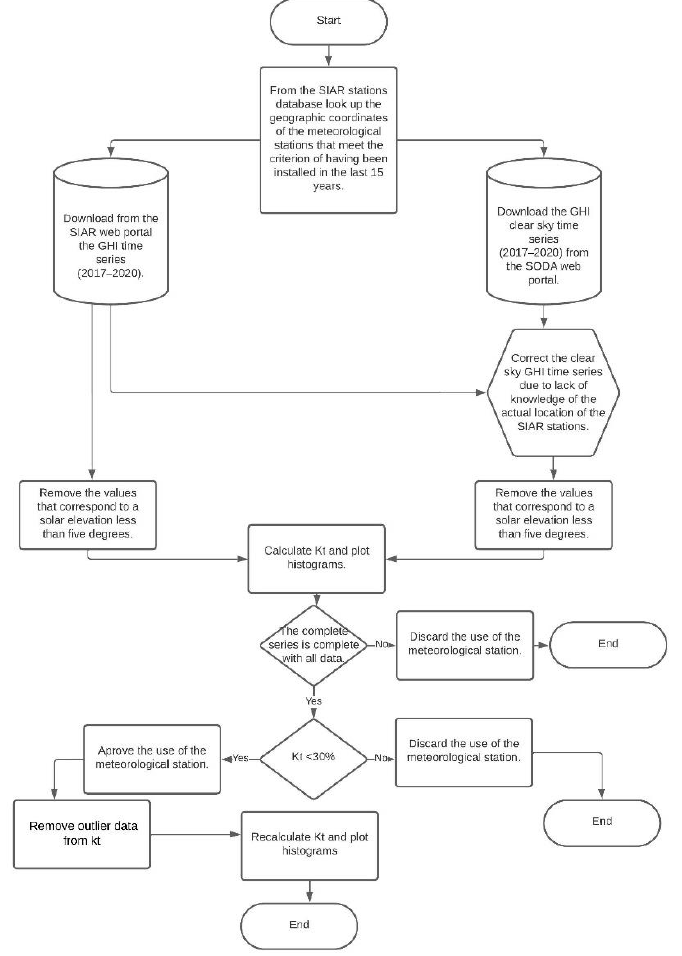
Figure 4. Proposed methodology for evaluation, correction, and cleaning of solar-irradiance data series.